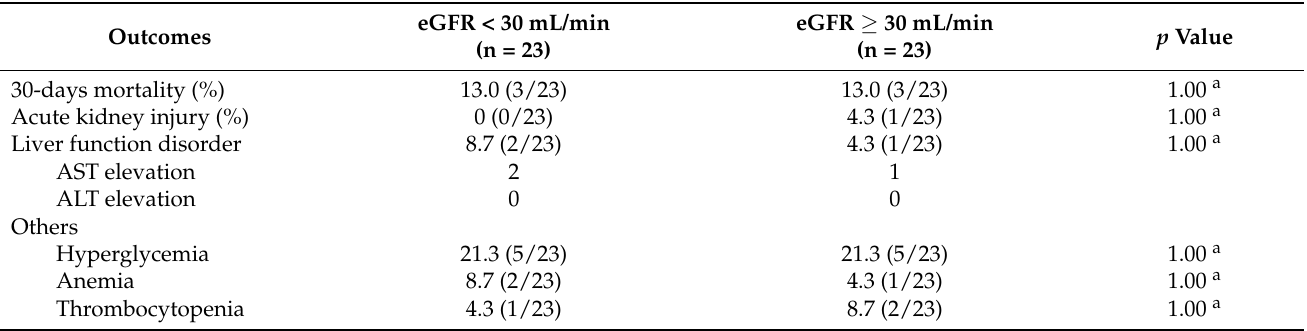
Table 2. Safety outcomes of patients with remdesivir administration after propensity score matching analysis.